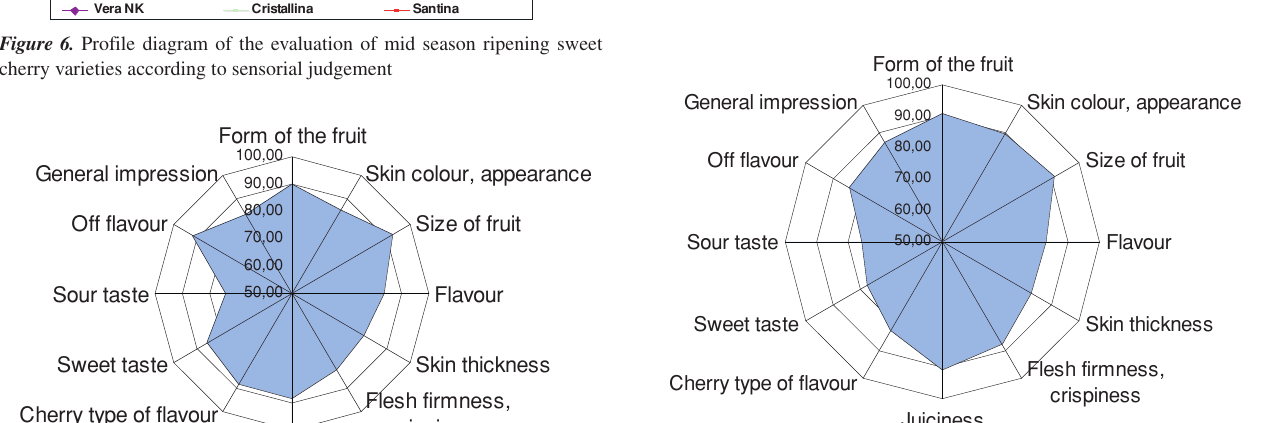
Figure 7. Profile diagram of the sensorial judgement of the variety Giant Red